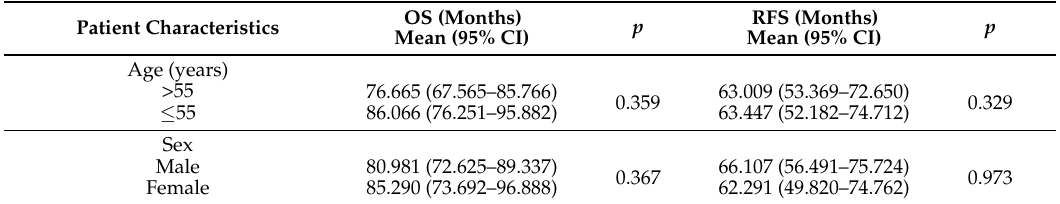
Table 2. Clinical and laboratory characteristics of 231 patients associated with overall survival (OS) and recurrence-free survival